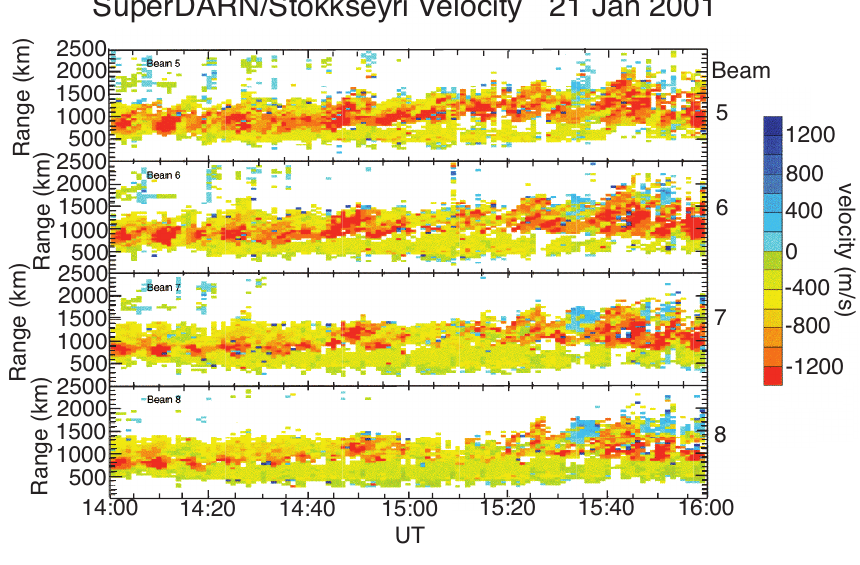
Fig. 9. Line-of-sight velocities measured in several beams of the Stokkseyri SuperDARN radar which point in the general direction of